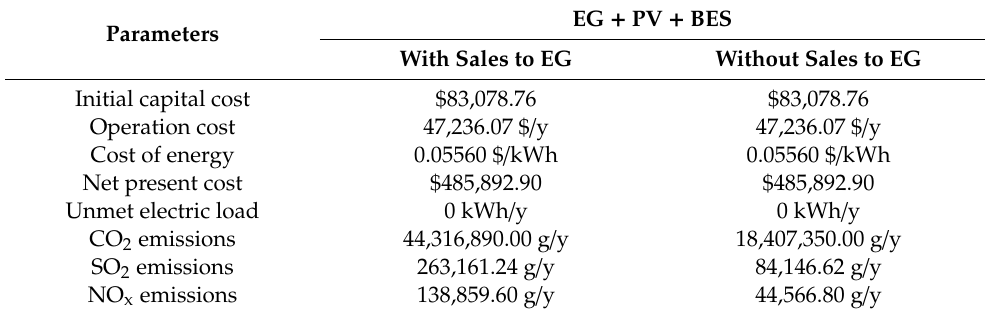
Table 10. Comparison of resilience and techno-economic and life cycle based environmental feasibility indicators for EG + PV + BES based power supply system configuration with and without sales to